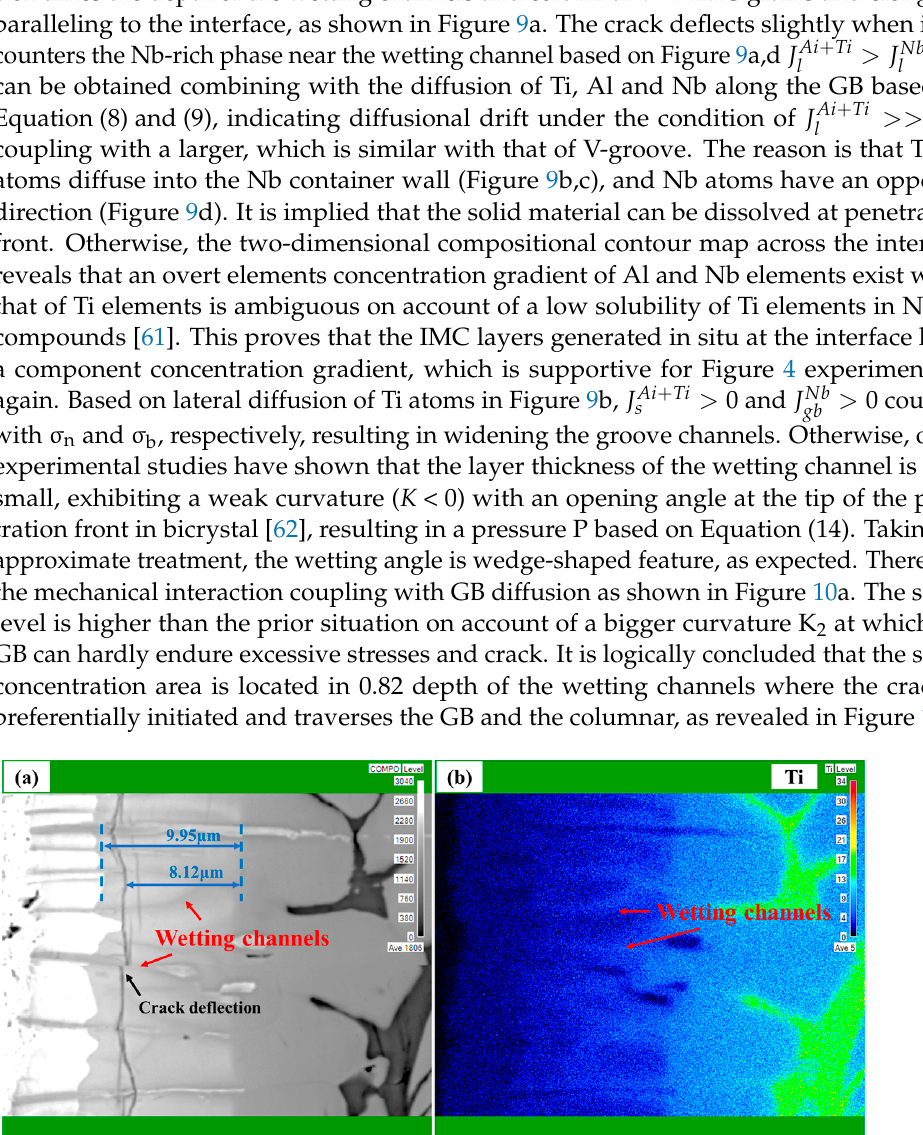
Figure 10. ( a ) Schematic illustration of the related stress interactions coupled with element diffusion, ( b ) Schematic illustration of Crack nucleation and propagation. Based on the previous experimental analysis, it is demonstrated that the nucleation and extension of the crack can be directly related to the depth of the V-grooves. 4.2.2. Mechanical Interaction and Crack Mechanism in U-Grooves The SEM micrograph of crack in a U-groove (such as in Figure 2c) and the relevant SEM-EDS lines scanning of the relevant elements along the dot lines shown in Figure 11. It can be seen that the transgranular crack without any branches extends continuously between K 1 and K 2 paralleling to the interface and deflects slightly near the GB, as por- trayed in Figure 11a. Otherwise, it is worth to note that the width of the crack at the bound- ary appears to be wider than that of in IMC grains and interior of the groove, implying the crack source is in the boundary. The concentration of Al, Ti elements deceasing along the GB (Figure 11c,g), respectively, and that of Nb has an opposite trend (Figure 11e), demonstrating